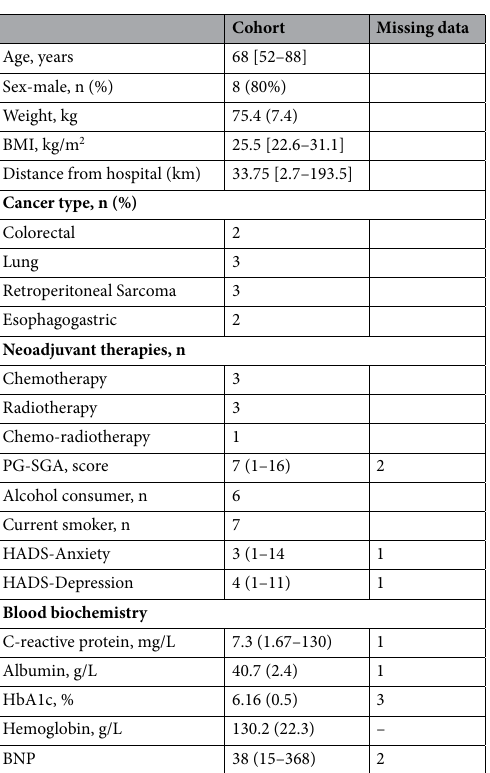
Table 1. Demographic and health characteristics. Data presented as the mean (SD), median [Range] or n (%); BMI, Body Mass Index; BNP, B-Natriuretic peptide; HADS, Hospital Anxiety and Depression Scale; HbA1c, Glycated hemoglobin; PG-SGA, Patient Generated Subjective Global Assessment; PG-SGA nutritional triage level score of 0–3, an intervention by a dietitian is unnecessary, 4–8, necessitating an intervention by a dietitian and ≥ 9, in critical need for nutrition